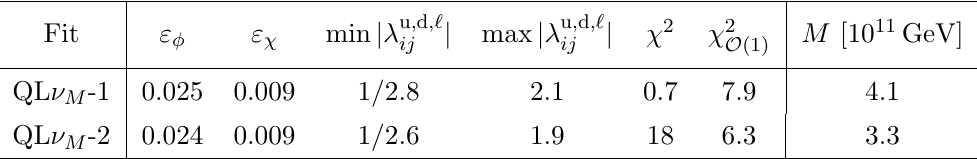
Table 10 . Best (cid:12)ts for the D 6 (cid:2) U(1) model including CKM phase and Majorana neutrinos. The complete set of parameters can be found in table 15.